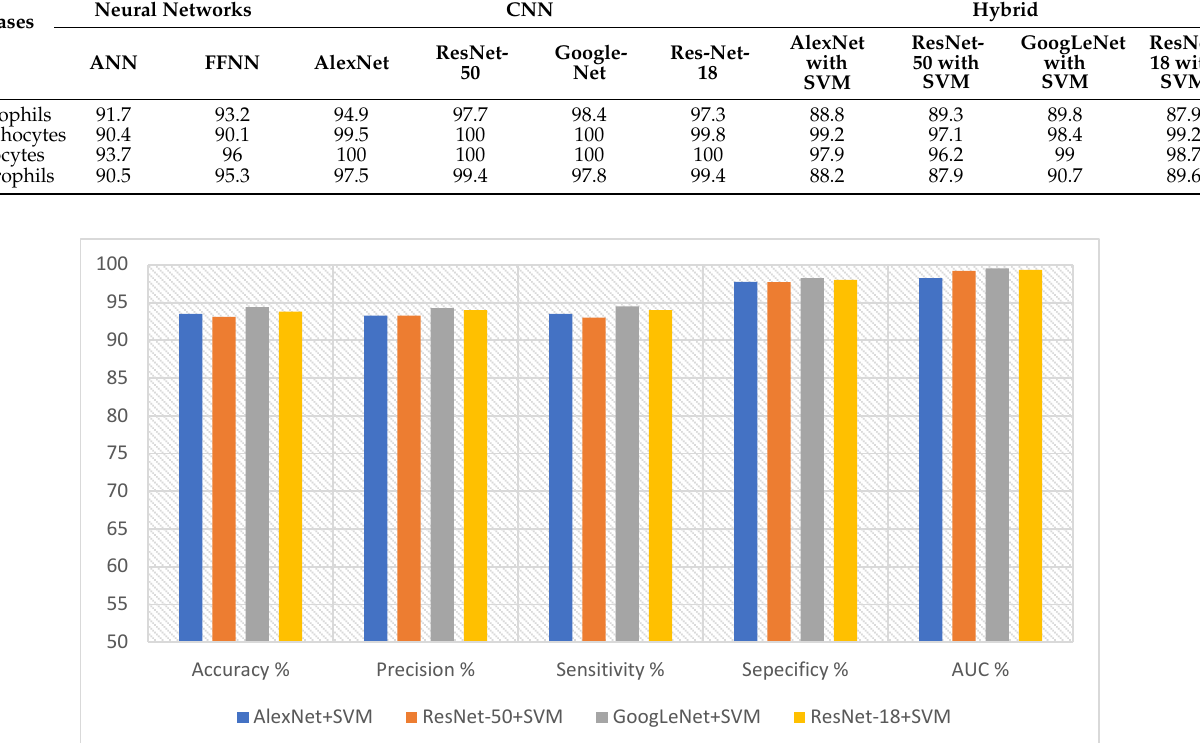
Figure 20. A comparison between the proposed systems for detecting WBC diseases.